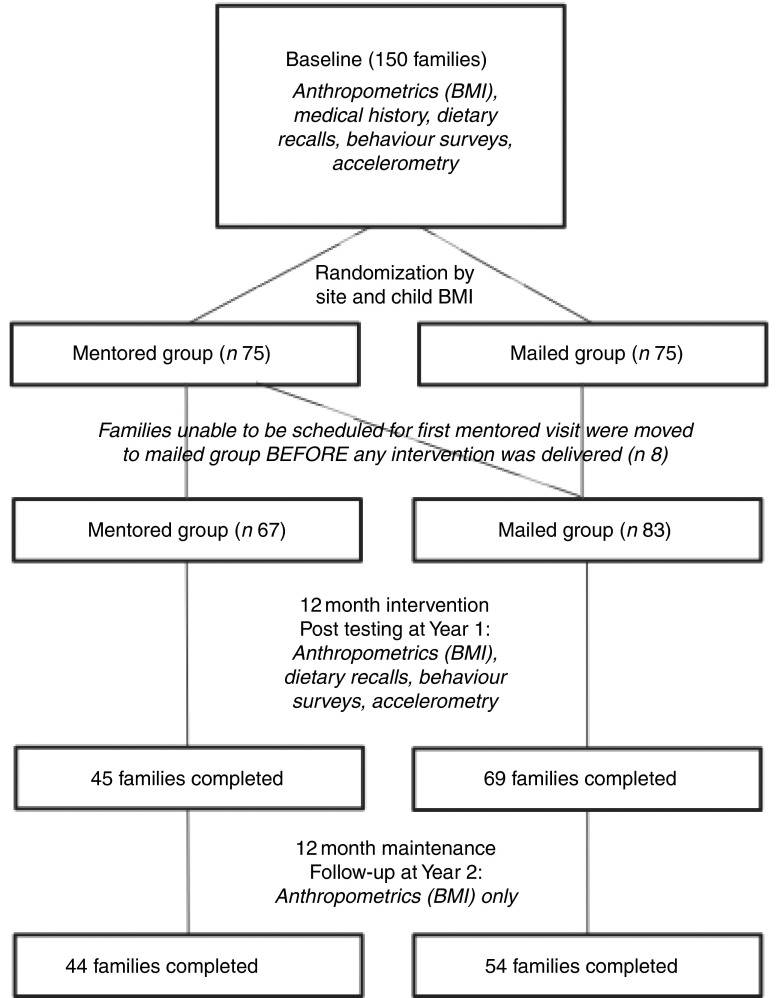
Healthy Children, Strong Families study flow diagram. ‘Family’ indicates the adult–child dyad